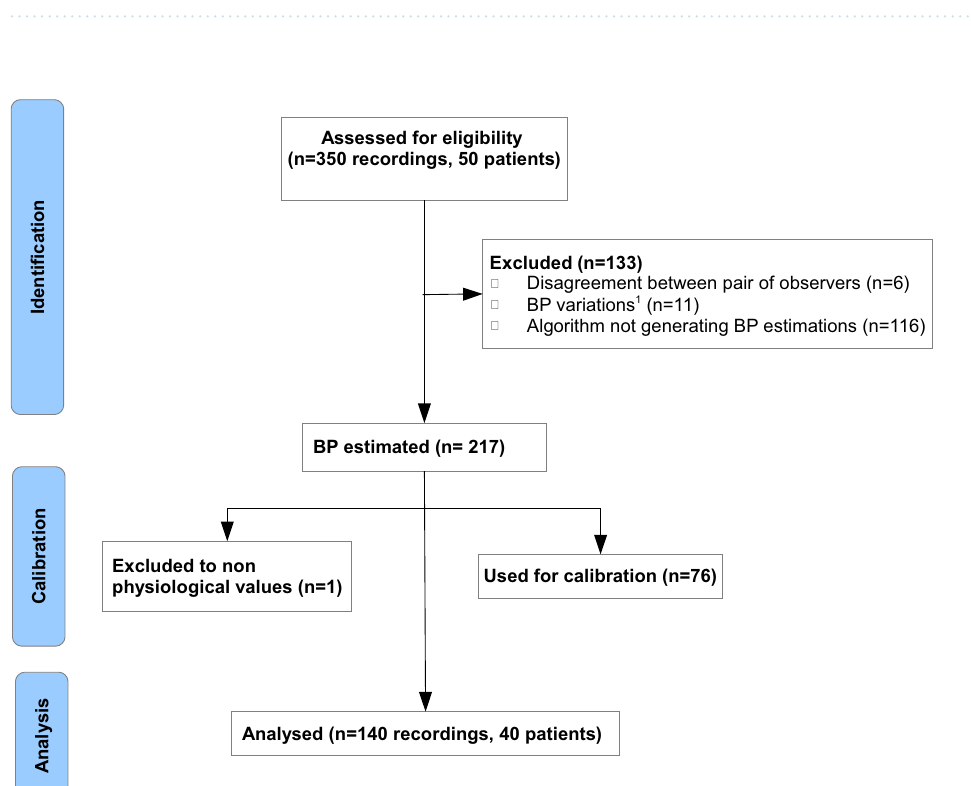
Table 4. Distribution of reference systolic and diastolic blood pressure (BP) measurements (n = 140) in OptiBP validation population.